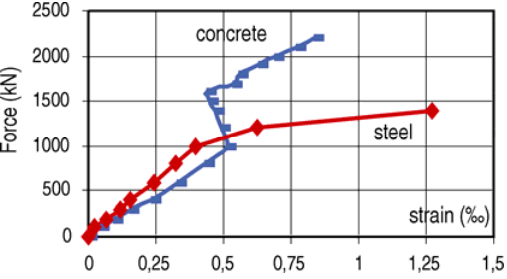
Fig 9 . Strains of steel and concrete in the middle height of composite column loaded through steel core cross-section